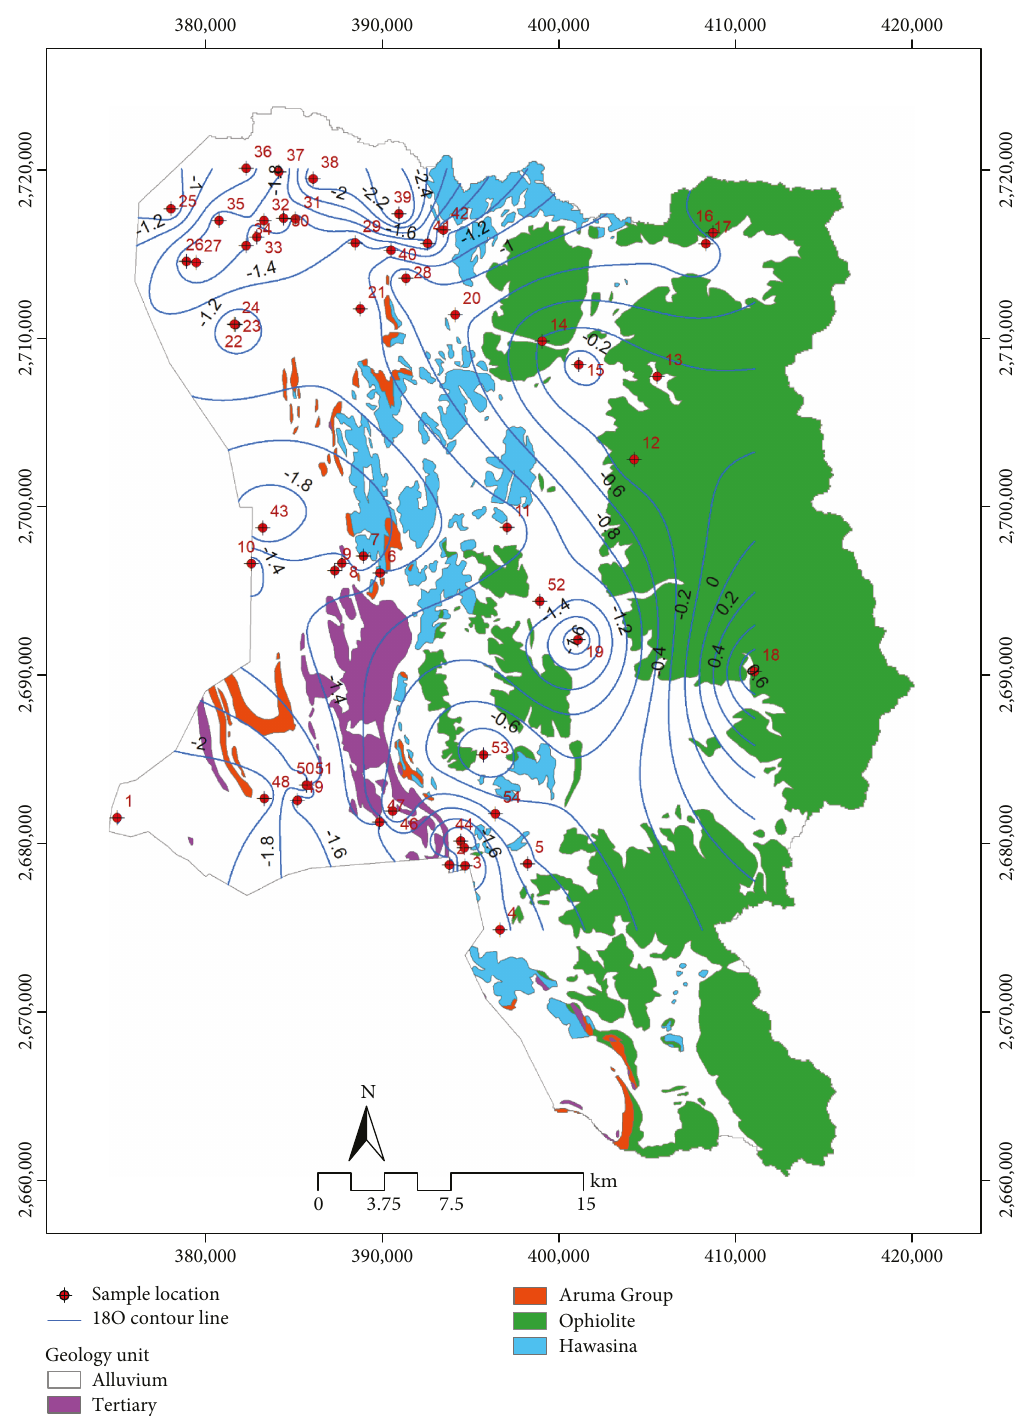
Figure 7: Contour lines of the oxygen-18 isotope. The isotopic concentration of the groundwater is progressively depleted in the direction of the fl